Question: What caption would you write for this figure?
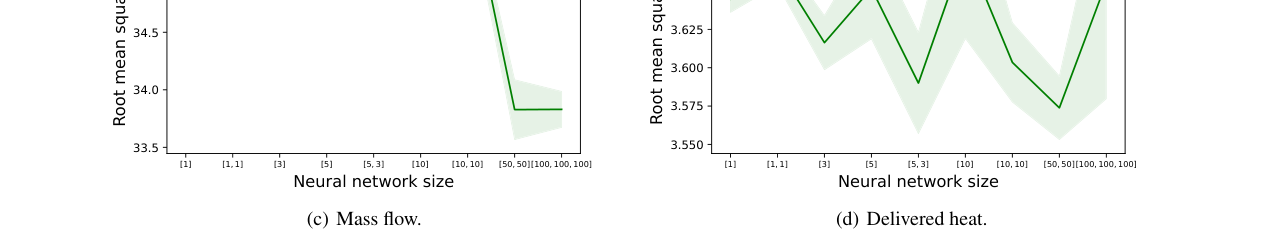
Answer: Root mean squared errors (y-axis) of one-step predictions with standard deviation over five repetitions for different neural network sizes (x-axis).